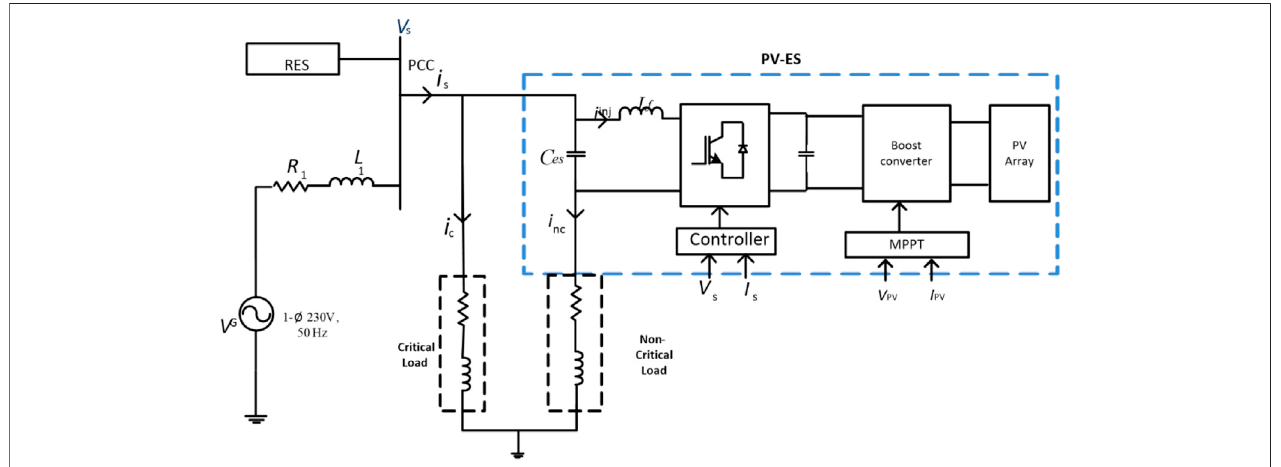
FIGURE 1 | Schematic diagram of the PV-ES